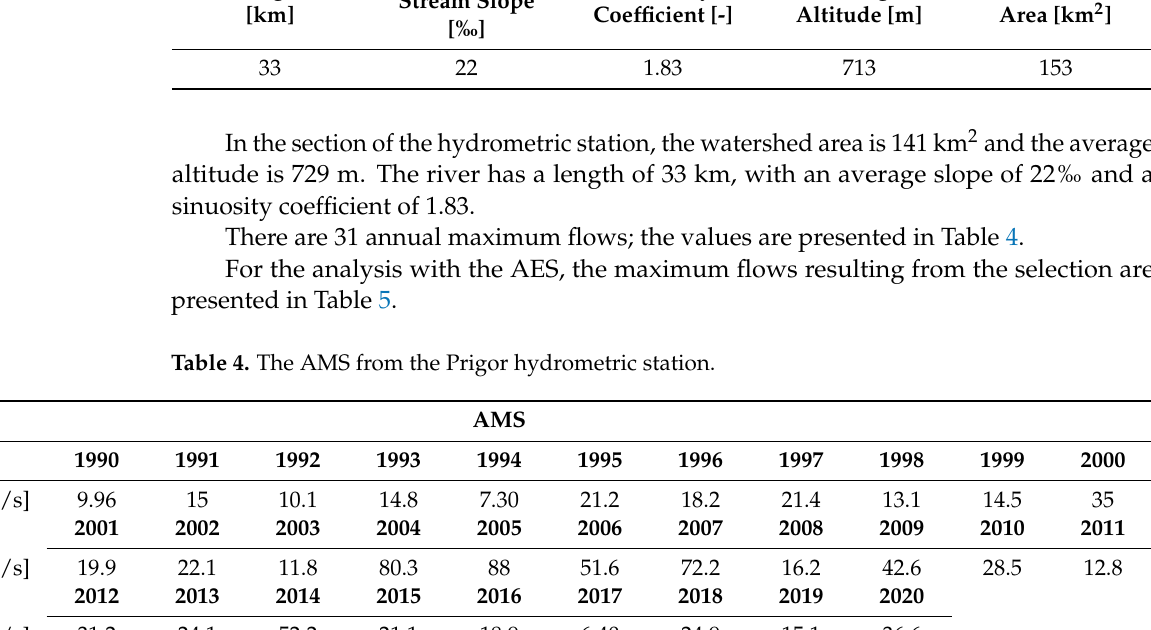
Table 5. The AES from the Prigor hydrometric station.